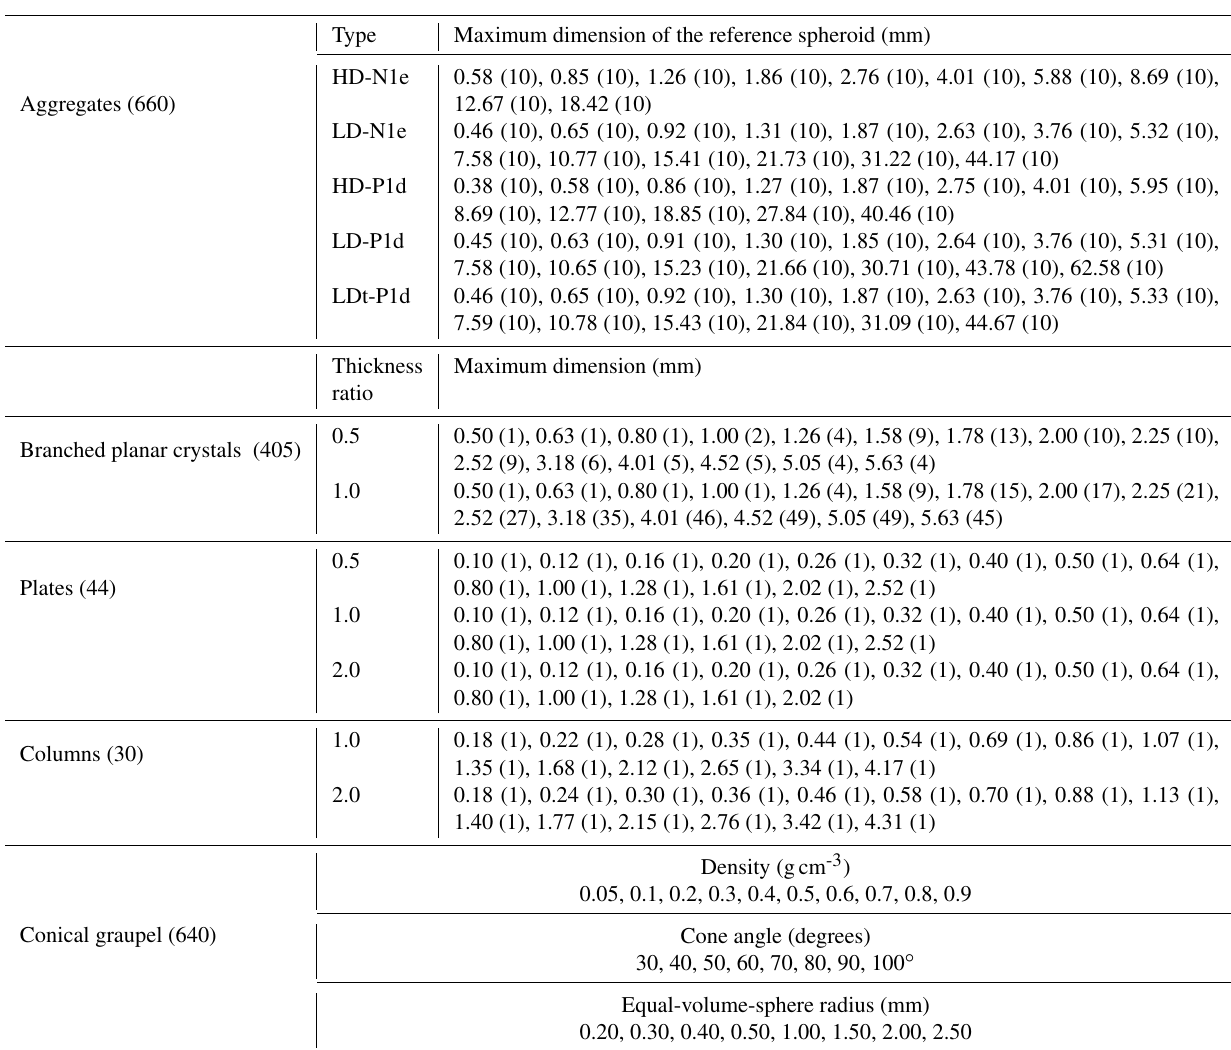
Table 2. Species and size information for the ice particles in the database. The number within parentheses below each ice-particle species is the total number of ice particles of that species in the database. The numbers in parentheses following the maximum dimensions of the aggregates (maximum dimensions of the reference spheroids for the aggregates), branched planar crystals, plates, and columns indicate the number of realizations (i.e., different ice particles) with that size. For conical graupel, with one realization for each combination of density, cone angle, and equal-volume-sphere radius, there are a total of 640 graupel particles in the